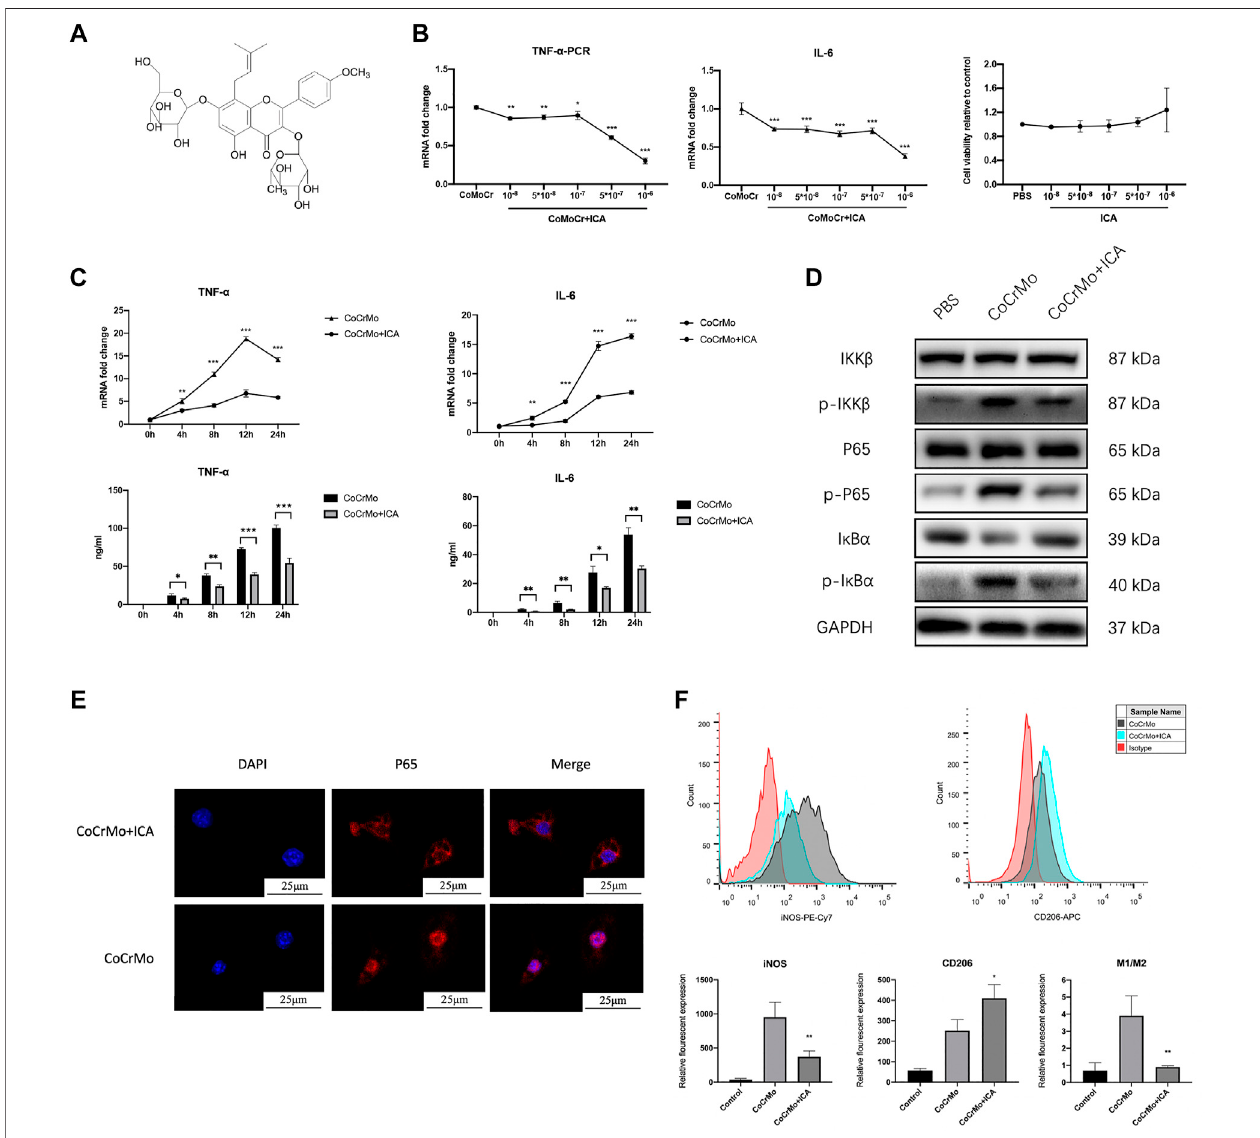
FIGURE 3 | ICA suppressed CoCrMo wear particle-induced activation of NF- κ B signaling and the expression of proin fl ammatory factors in BMDMs. (A) The chemical structure of ICA. (B) The inhibitory effect ofICA on CoCrMo wear particle-induced TNF- α and IL-6mRNA expression inBMDMswasdose-dependent (10 − 8 to 10 − 6 M). No signi fi cant changes in cell viability were observed when the ICA concentration was varied from 10 − 8 to 10 − 6 M. (C) The mRNA expression and secretion of TNF- α andIL-6inBMDMsdecreasedsigni fi cantlyintheICAgroup. (D) Markeddecreasesinp-IKK β ,p-p65andp-I κ B α proteinexpressionwereobservedafterICA treatment. (E) CoCrMo-induced translocation of p65 (red) from the cytoplasm into the nucleus (blue) was reduced in the CoCrMo + ICA group. (F) A decreased mean fl uorescent expression of iNOS and an increased mean fl uorescent expression of CD206 were found after ICA treatment. * indicates p < 0.05, ** indicates p < 0.01, and *** indicates p < 0.001 when compared with the control group at the same time